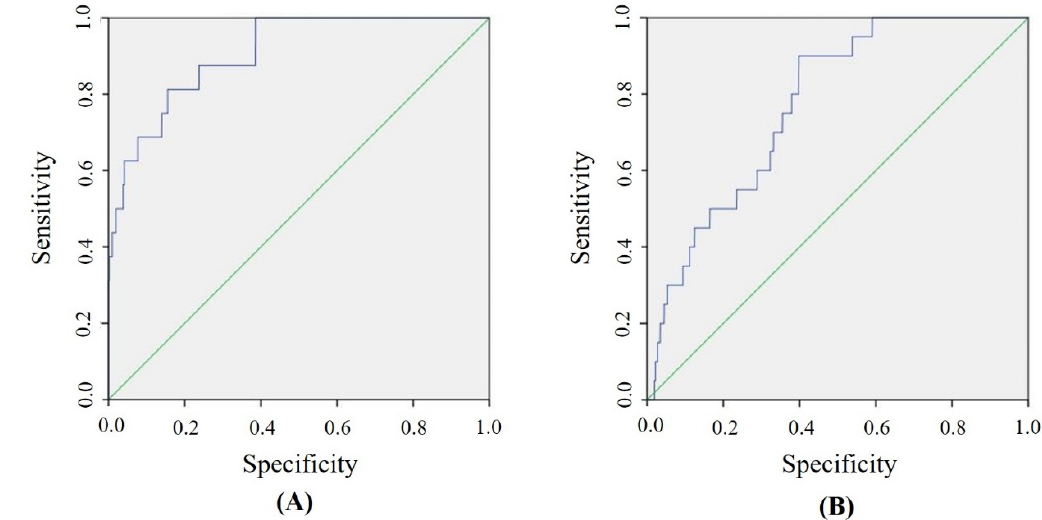
Figure 1. Receiver operating characteristic (ROC) curves of the docking results for the compounds from the Zinc In Man (ZIM) database were ( A ) urease with AUC = 0.90 and ( B ) shikimate kinase with AUC = 0.77. The diagonal green line indicates an area under curve (AUC) value of 0.50, meaning results occurred by chance. An AUC value between 0.7 and 1.0 indicates the results had reliable sensitivity and specificity.